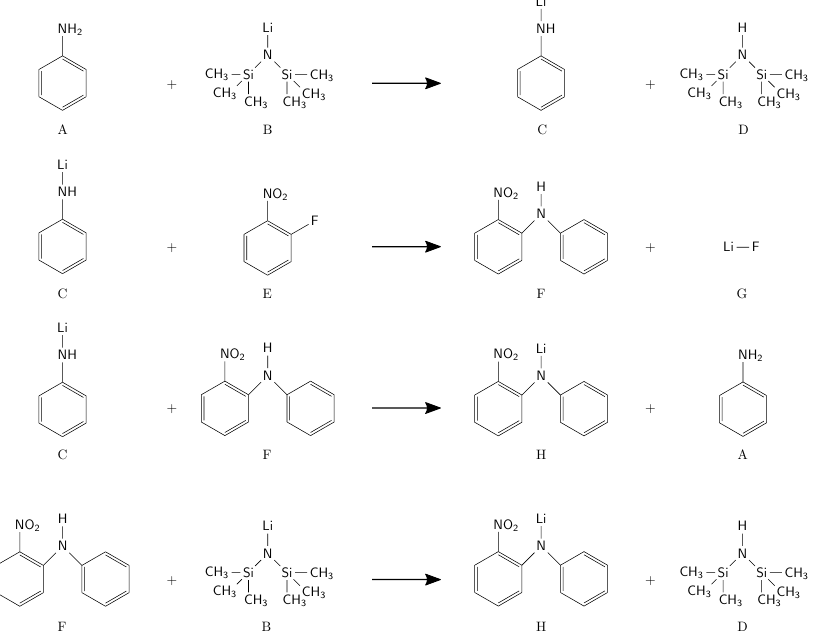
Figure 9. Detailed reaction mechanism of lithiation reaction. Names of the chemical components are given in Table